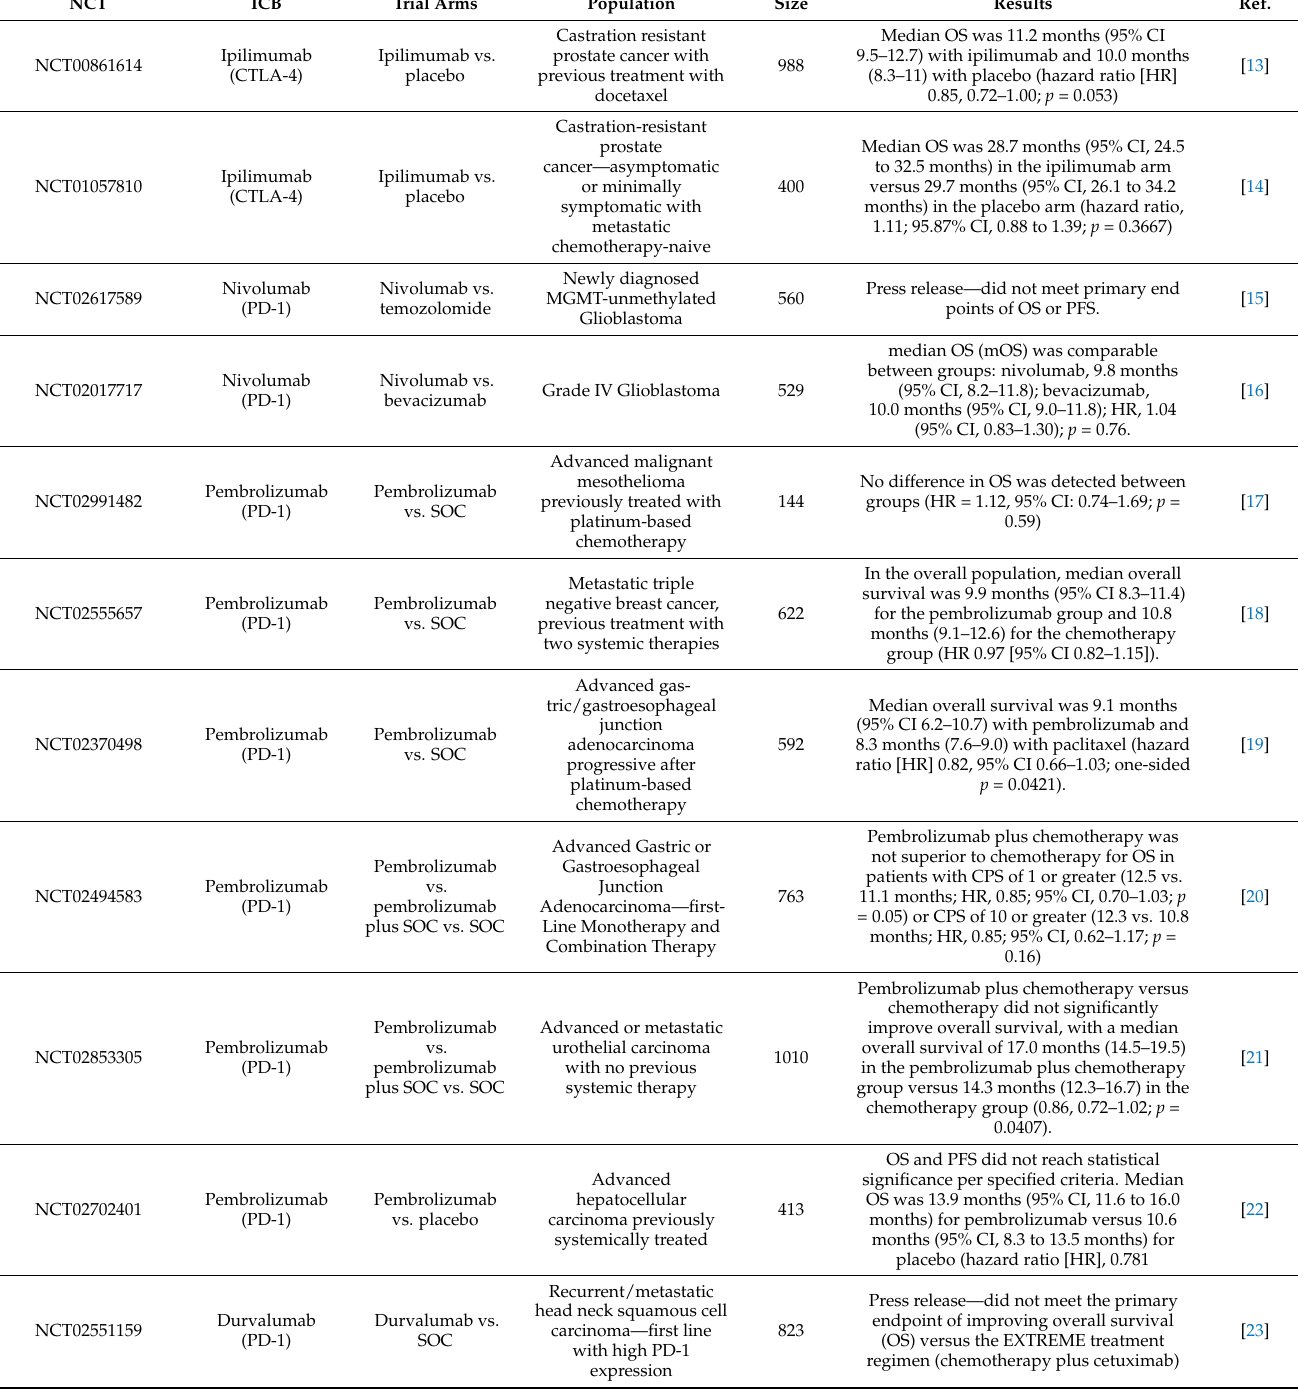
Table 1. Selected immunotherapy clinical trials, over the last ten years, which demonstrated no benefit. Abbreviations: HR—hazard ratio (Hazard ratio is the ratio of hazard rates between two different treatment groups. A hazard ratio of 1 indicates there is no difference in hazard rates between the two groups. Hazard ratios below 1 indicate that the treatment might be favorable). NSCLC— non-small cell lung cancer, OS—overall survival, PD-1—programmed death 1, PFS—progression free survival, SCLC—small cell lung cancer, SOC—standard of care. Size Results